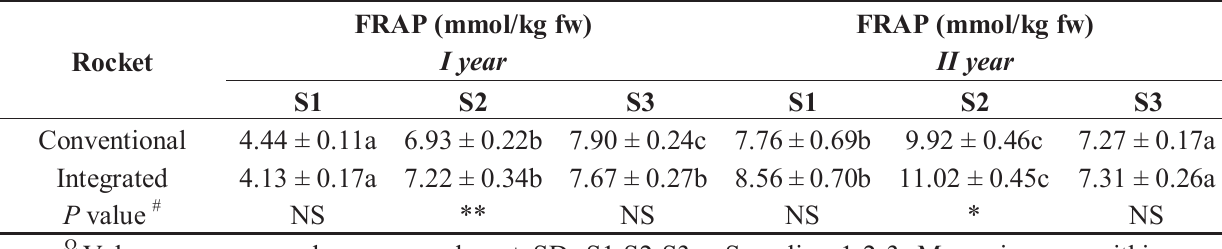
(cid:525) Values are expressed as mean values ± SD; S1-S2-S3 = Samplings1-2-3; Means in rows within same year followed by different letters differed significantly ( P < 0.001, P < 0.01 or P < 0.05); # By column, levels of significance are represented by * P < 0.05, ** P < 0.01 and NS not